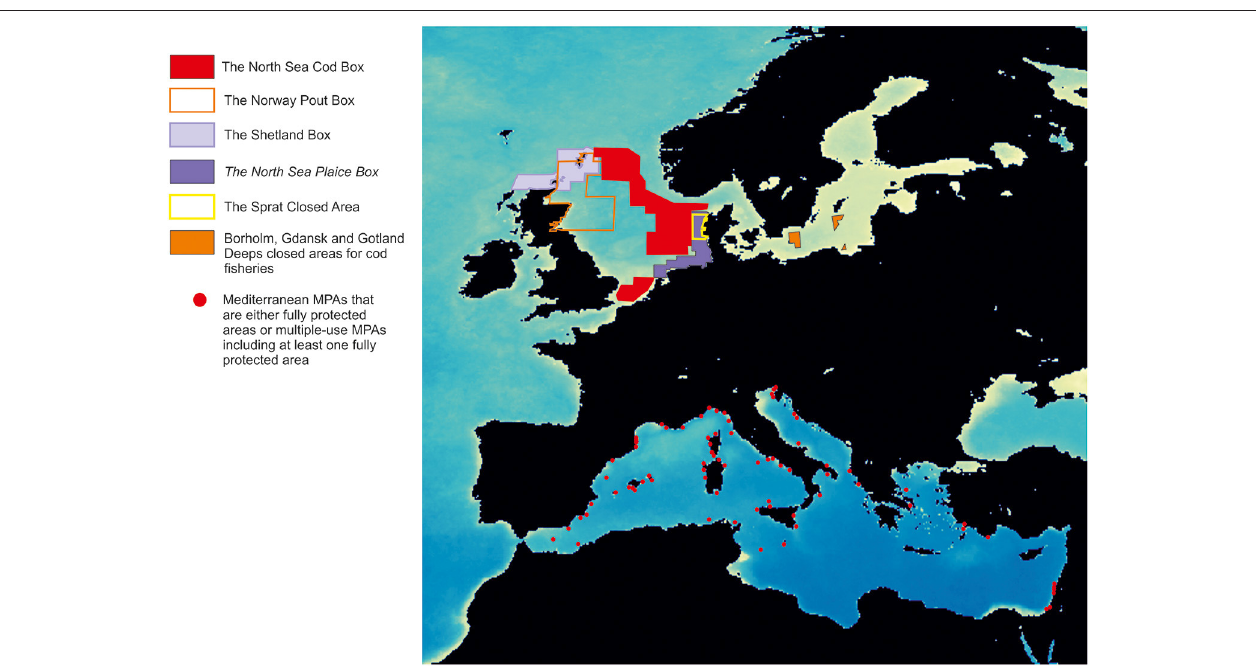
FIGURE 1 | Main fish closures in the North and Baltic Seas (Sørensen, 2006) and distribution of present Mediterranean MPAs in April 2017 (MAPAMED, 2017; http:// www.medpan.org/en/mapamed). Base map corresponds to averaged maximums of Chlorophyll a for the period 2003–2010 from satellite